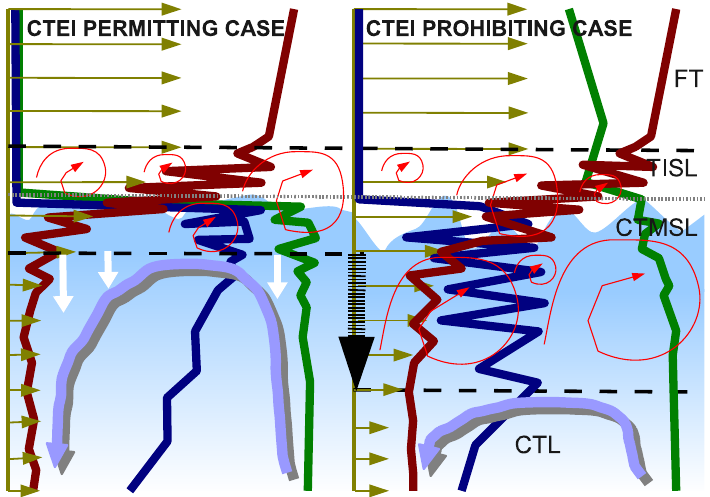
Fig. 16. Cartoon summarizing the main physical mechanisms of mixing in stratocumulus top in CTEI-permitting and -preventing sit- uations. FT – free troposphere; TISL – turbulent inversion sublayer; CTMSL – cloud-top mixing sublayer; CTL – cloud-top layer. EIL = TISL + CTMSL– entrainment interface layer, between black dashed lines. Straight brown arrows – mean wind; thin spiral brown arrows – turbulent eddies due to shear; double violet-grey lines – convective circulations in the STBL; green and blue lines – θ l and LWC profiles from airborne measurements. White arrows in the left panel indicate removal of negatively buoyant parcels from the EIL in the CTEI-permitting case, while black dashed arrow indicates buildup of the CTMSL in the CTEI-prohibiting case.